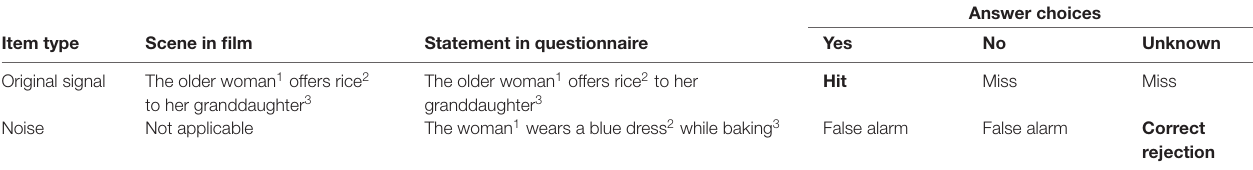
TABLE 5 | Scoring matrix for hits and false alarms used in the secondary analysis without the reversed signal items.